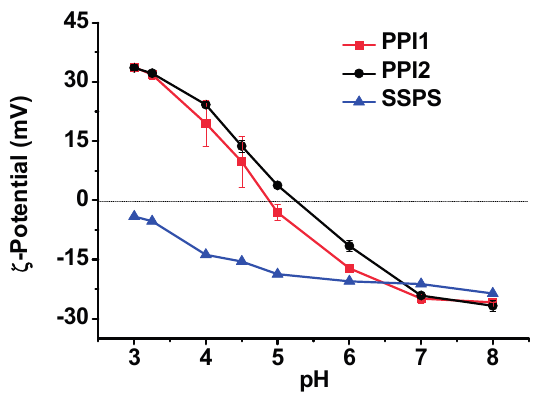
Figure 3. ζ -Potentials of PPI1, PPI2, and SSPS solutions as a function of pH.